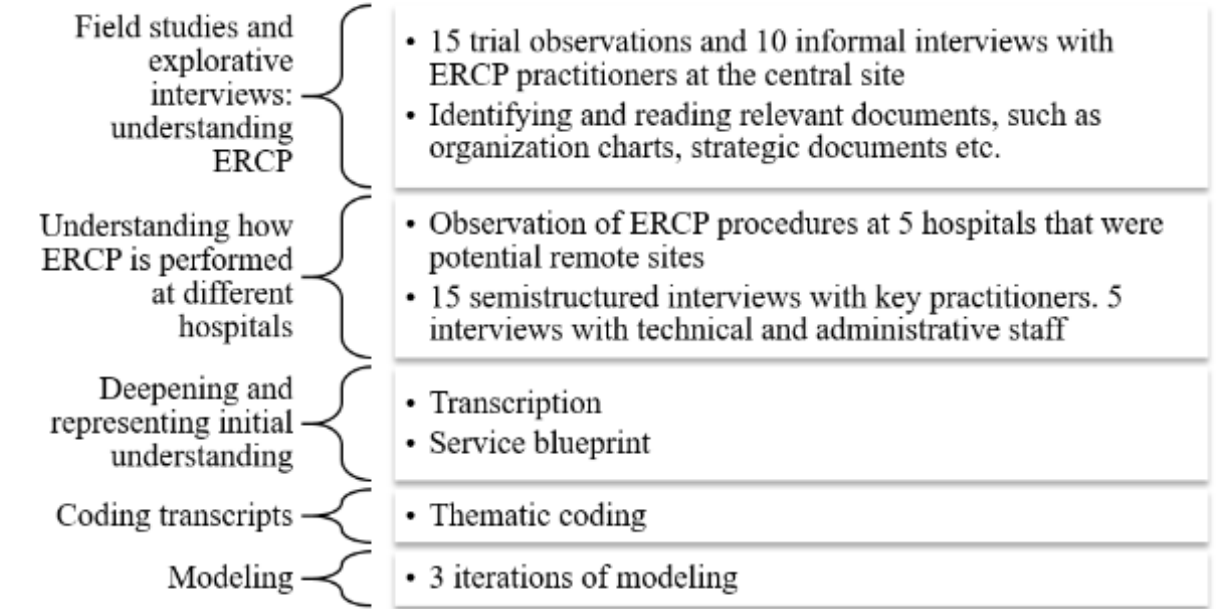
Figure 1. Phases in data collection, analysis, and